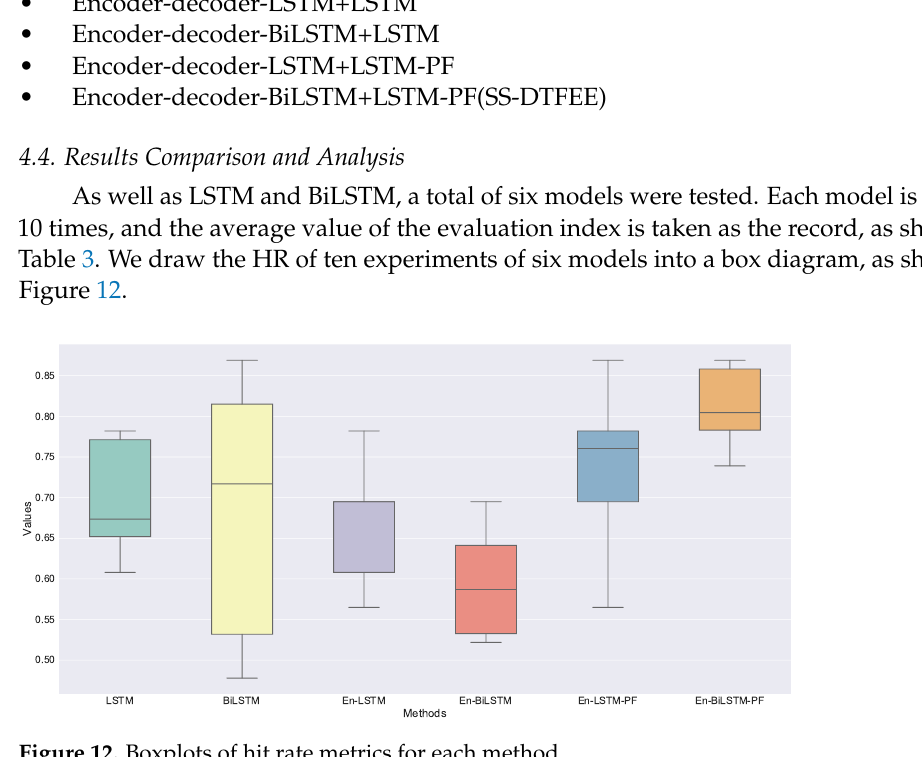
Figure 12. Boxplots of hit rate metrics for each